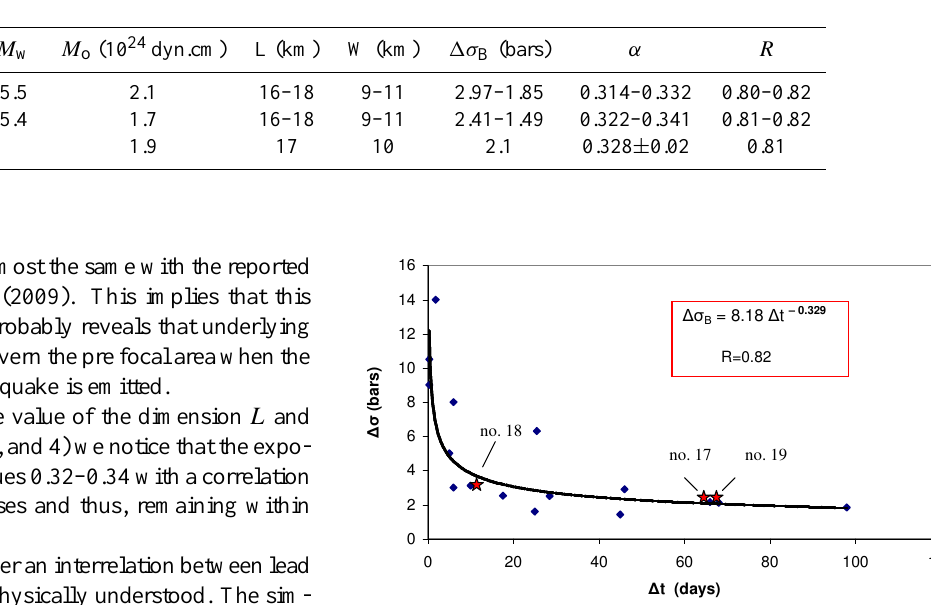
Table 4. The date, the magnitude M w and the seismic moment of event no. 19 along with the range of values in the dimensions of the aftershock area L and W, the corresponding calculated values for 1σ B , the critical exponent α and the associated correlation coefficient R . Mean values are given in the last row.